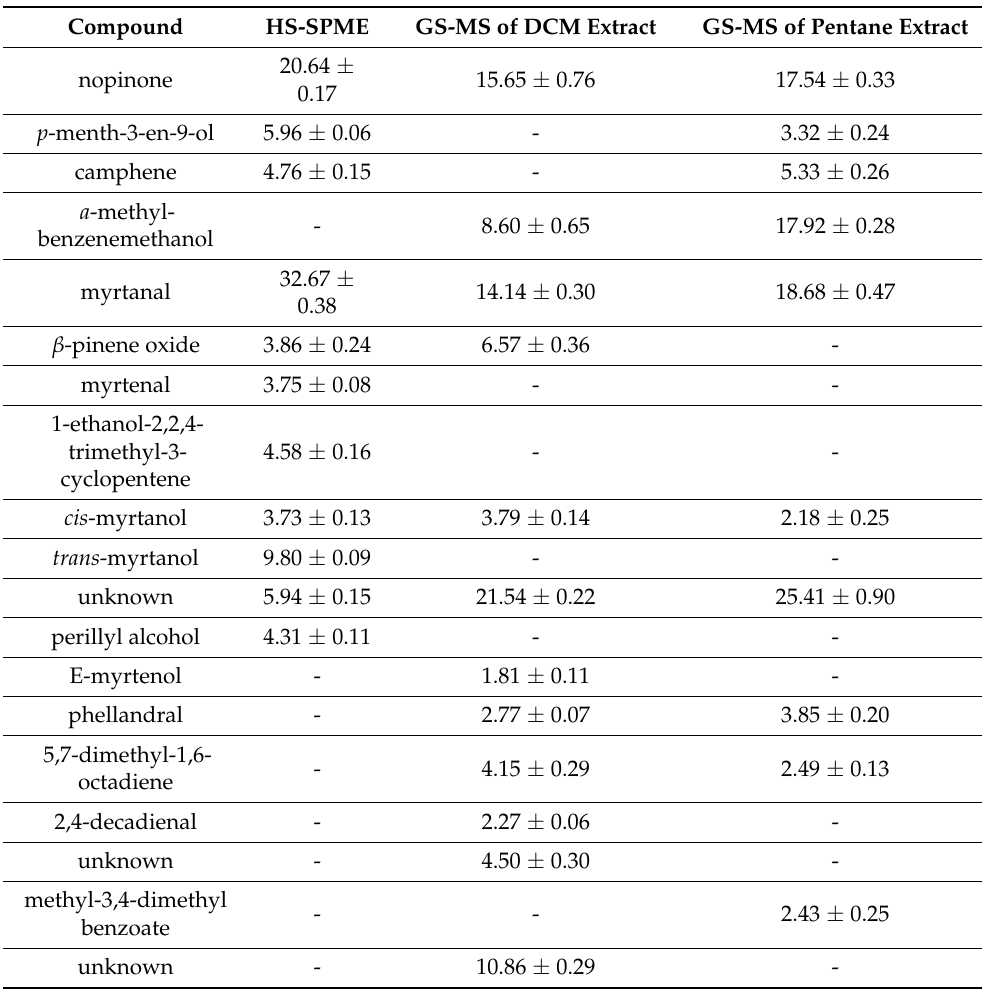
Table 2. Tentative identification of compounds of RS extracts from Paeonia clusii subsp. rhodia via GC-MS (%